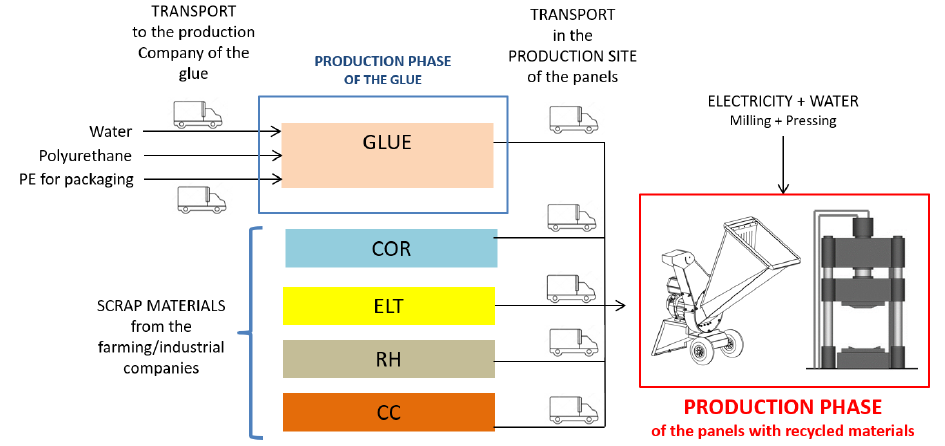
Figure 3. Flow chart of the LCA analysis from the cradle to the gate.